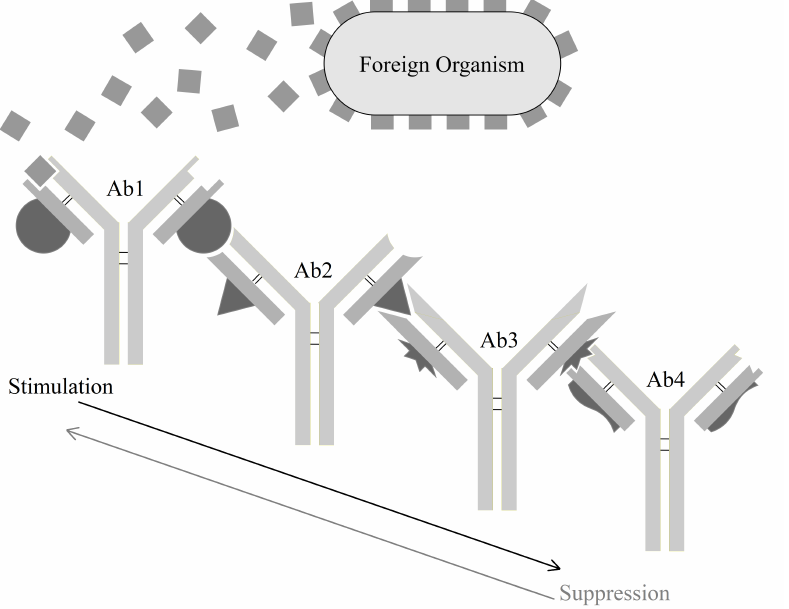
Figure 4. Richter’s model [22] of an antibody chain. Each antibody is labeled Abx and the antigens are pictured as dark squares. This example showcases how an antigen can trigger a cascade of reactions. The presence of the antigen is initially recognized by Ab 1, which increases in number. This leads to Ab 2 to start recognizing Ab 1 that prompts Ab 2 to increase in number and so on. As the